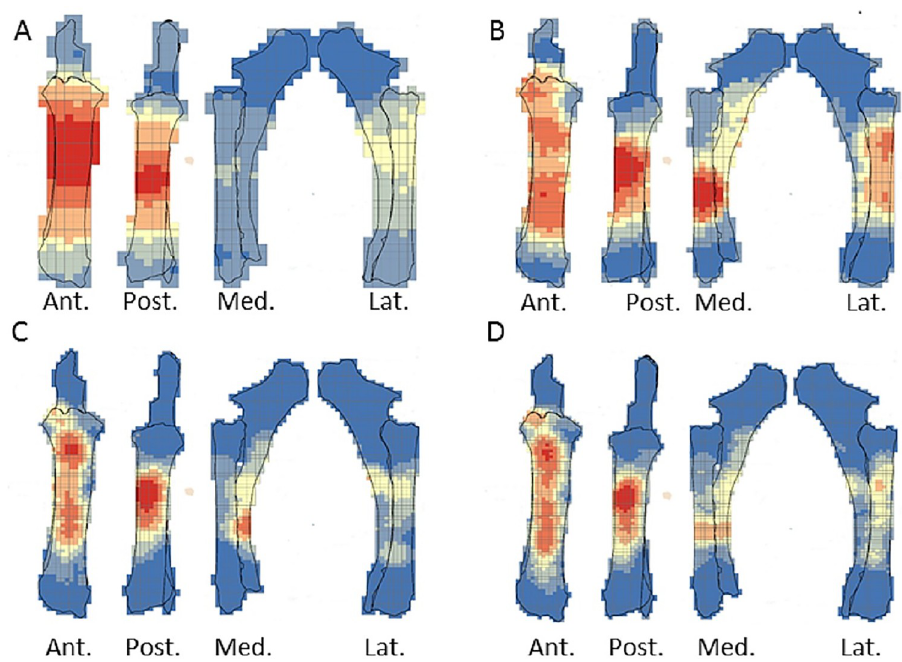
Fig 7. Optimized hot spot analysis of combined percussion marks from the radio-ulnas in each series. A- Individual n˚2; B- Individual n˚9; C- Individual n˚12; D- Merged radio-ulnas series (Ind.: Individual).